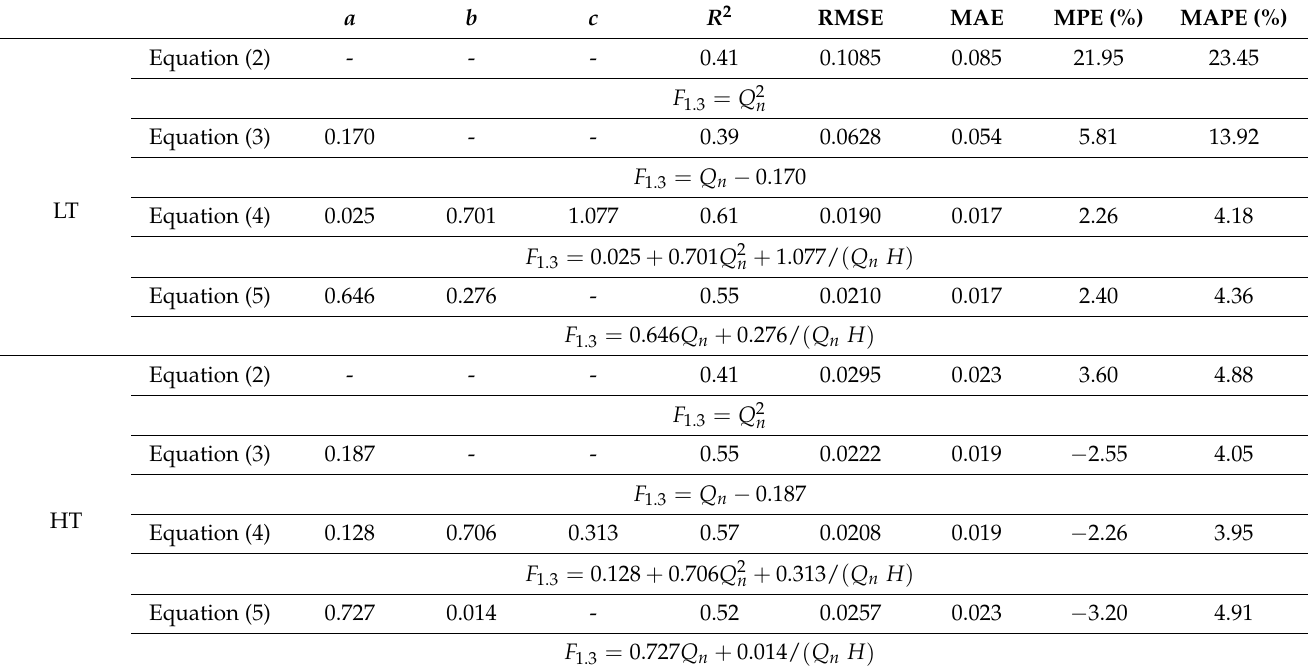
Table 1. Four model parameters and estimation errors.